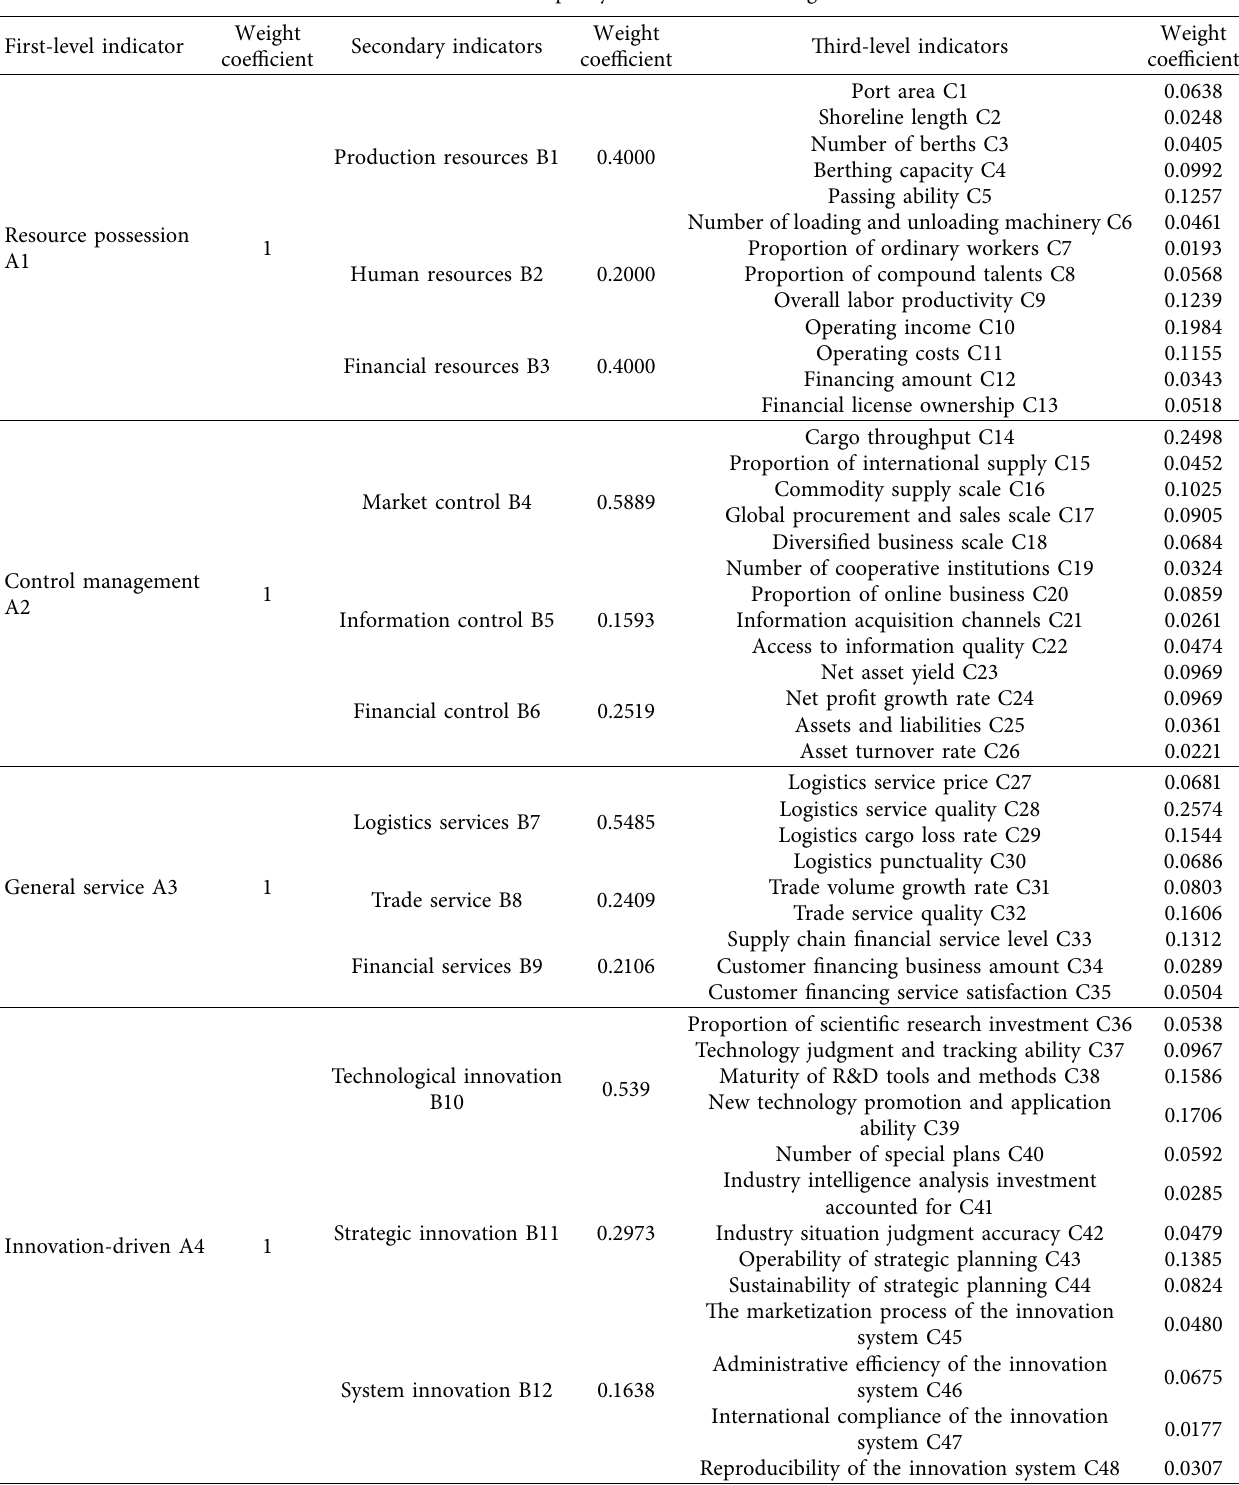
Table 1: Port capacity evaluation index